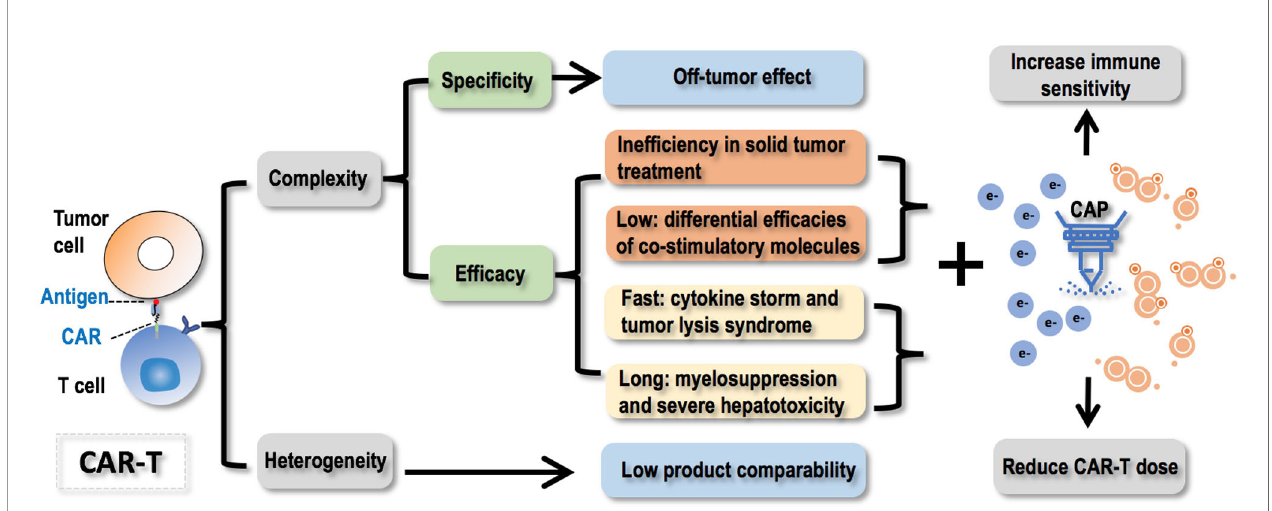
FIGURE 4 | Conceptual scheme illustrating challenges faced by CAR-T therapies, opportunities CAP provided to resolve these problems, and the ultimate goal towards the complete harness of CAR-T cells as a key element of the next generation of precision medicine. CAR-T therapies are dif fi cult to control and heterogeneous in nature. Regarding the ‘ uncontrollability ’ , failure in controlling the speci fi city will lead to the off-tumor effect; failure in controlling the ef fi cacy can be casted from 4 aspects that fall into two categories, i.e., ‘ inef fi ciency ’ including ‘ inef fi ciency in solid tumor treatment ’ and ‘ differential ef fi cacies of co-stimulatory molecules ’ , ‘ over-ef fi ciency ’ including ‘ cytokine storm and tumor lysis syndrome due to too fast therapeutic response ’ and ‘ myelosuppression and severe hepatotoxicity ’ due to long-lasting treatment ef fi cacy. Regarding the ‘ heterogeneity ’ feature, it will lead to low product comparability. CAP (cold atmospheric plasma) offers opportunities solving these challenges by increasing the immune sensitivity of cancer cells and reducing the dose of CAR-T to achieve improved or comparable ef fi cacy with reduced recurrence and increased safety. Faced by these problems, joint efforts from biologists, computational scientists, and clinicians are needed to collaboratively advance the strategies and technologies to improve our controllability on the speci fi city and ef fi cacy of CAR-T therapies, as well as fi nd a balance between the personalization and generalization of such promising